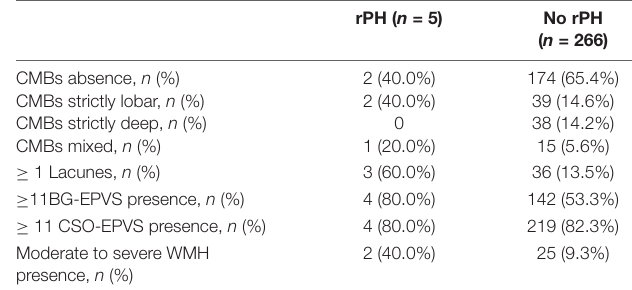
TABLE 2 | Baseline clinical and radiological characteristics for patients with and without rPH after